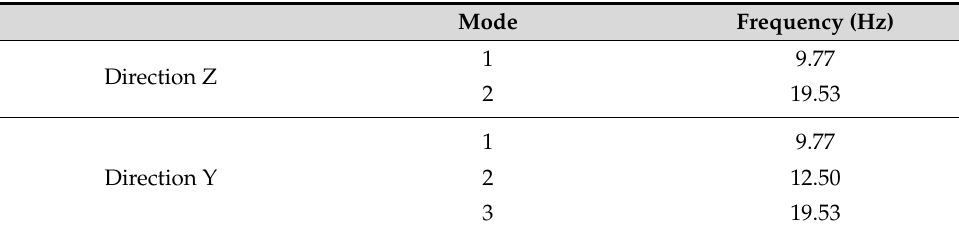
Table 2. Peak values shown by the PSDs of Figure 9 associable to structural modes.